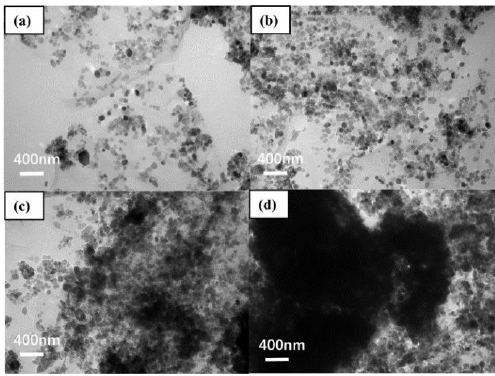
Figure 1. Transmission electron micrographs: ( a ) CeO 2 – GO (2:1); ( b ) CeO 2 – GO (4:1); ( c ) CeO 2 – GO